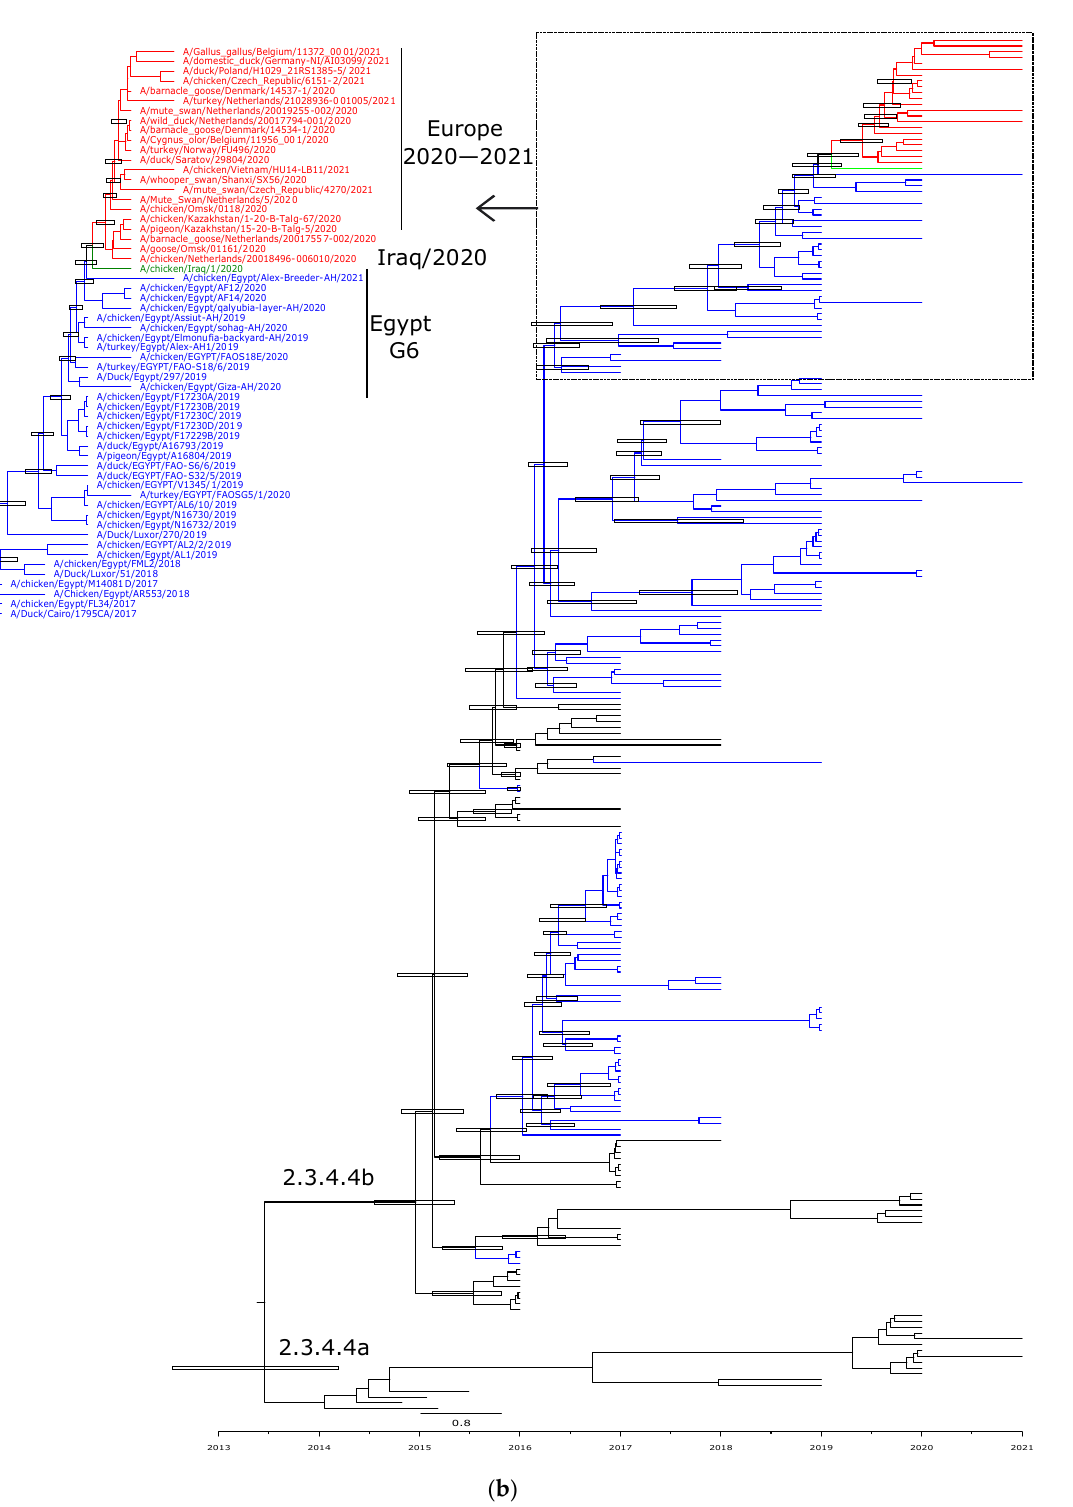
Figure 2. Time-scaled Bayesian maximum clade credibility tree of the ( a ) HA gene and ( b ) NA gene segment of HPAI H5N8 viruses from Egypt (blue) and representative H5N8 viruses from clade 2.3.4.4a and 2.3.4.4b. Node bars represent 95% Bayesian credible intervals for estimates of common ancestry, which are shown on the main nodes.